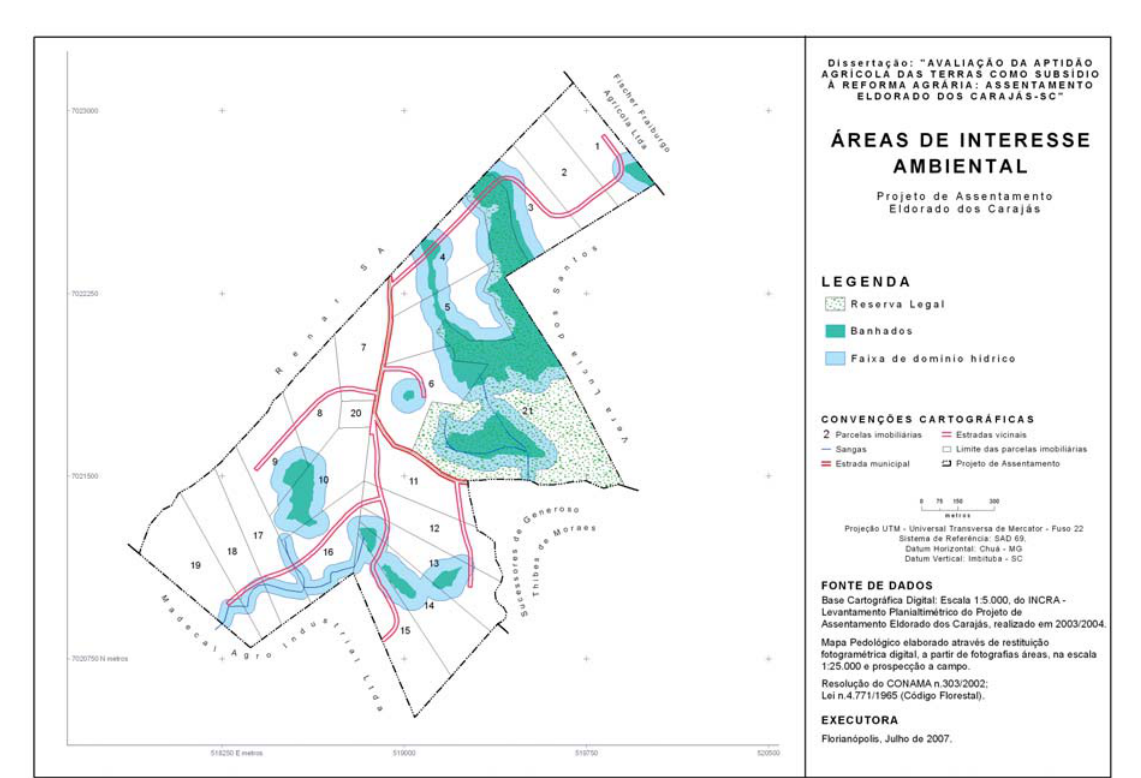
Figura 3. Mapa de áreas de interesse ambiental do